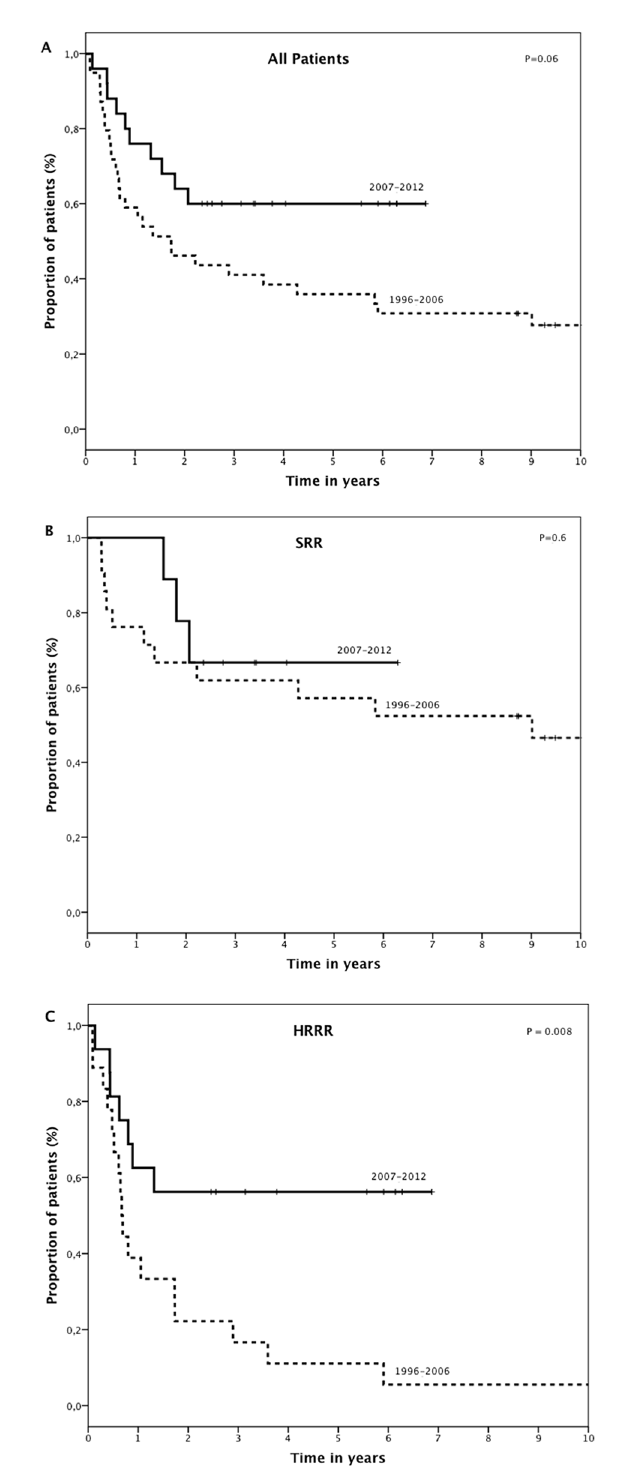
Fig 3. EFS by strategy. Before 2007, all relapsed patients were offered an hematopoietic stem cell transplantation (HSCT) after a single cycle of chemotherapy. After 2007, HSCT was offered to patients with high risk relapse, after at least 3 cycle of chemotherapy (A) 5-year EFS of all relapses or refractoriness: 41% vs 60%, (B) 5-years EFS of standard risk relapses (SRR): 57% vs 67%, and (C) 5-years EFS of high risk relapses or refractory (HRRR): 11% vs